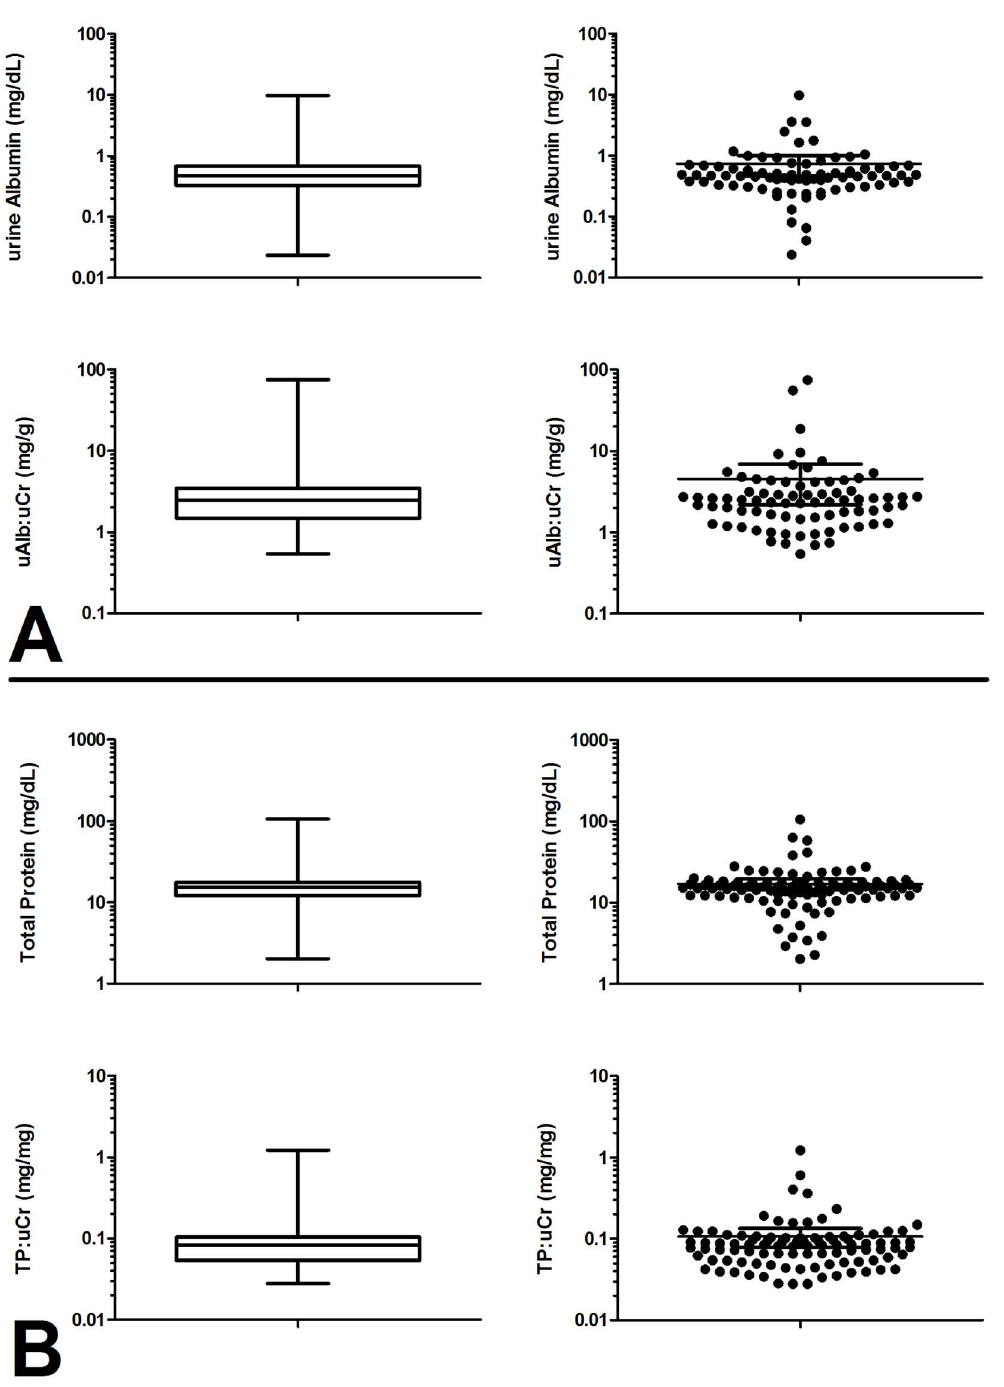
Figure 1. Distribution of urine albumin and total protein levels in healthy donors. A. Box-whisker and scatter plots of urine albumin distributions in urines. (Top panels: urine albumin concentration in mg/dL; Bottom panels: ratio of urine albumin to urine creatinine in mg/g). B. Box- whisker and scatter plots of urine total protein distributions in urine. (Top panels: urine total protein concentrations in mg/dL; Bottom panels: ratio of urine total protein to urine creatinine in mg/mg). Urine albumin, creatinine, and total protein were measured in urines obtained from 103 healthy donor by bead-based immunoassay, ELISA, and Bradford method, respectively. Boxes represent 25–75 th percentiles, whiskers represent range.